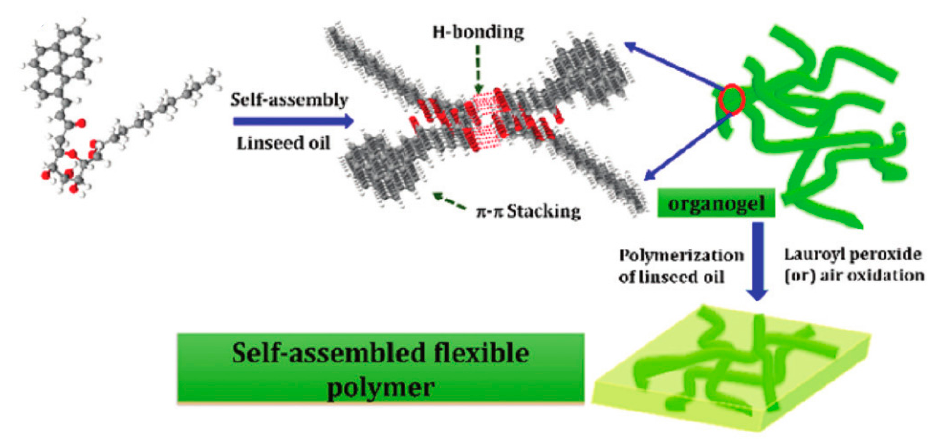
Figure 5. Hierarchical assembly of a semiconductive organogel by Muthusamy et al. from bio-based plant oils, which could be formed into flexible sheets for use as a charge transport layer in organic field effect transistors [54]. Adapted with permission from ref [54]. Copyright 2016 Royal Society of